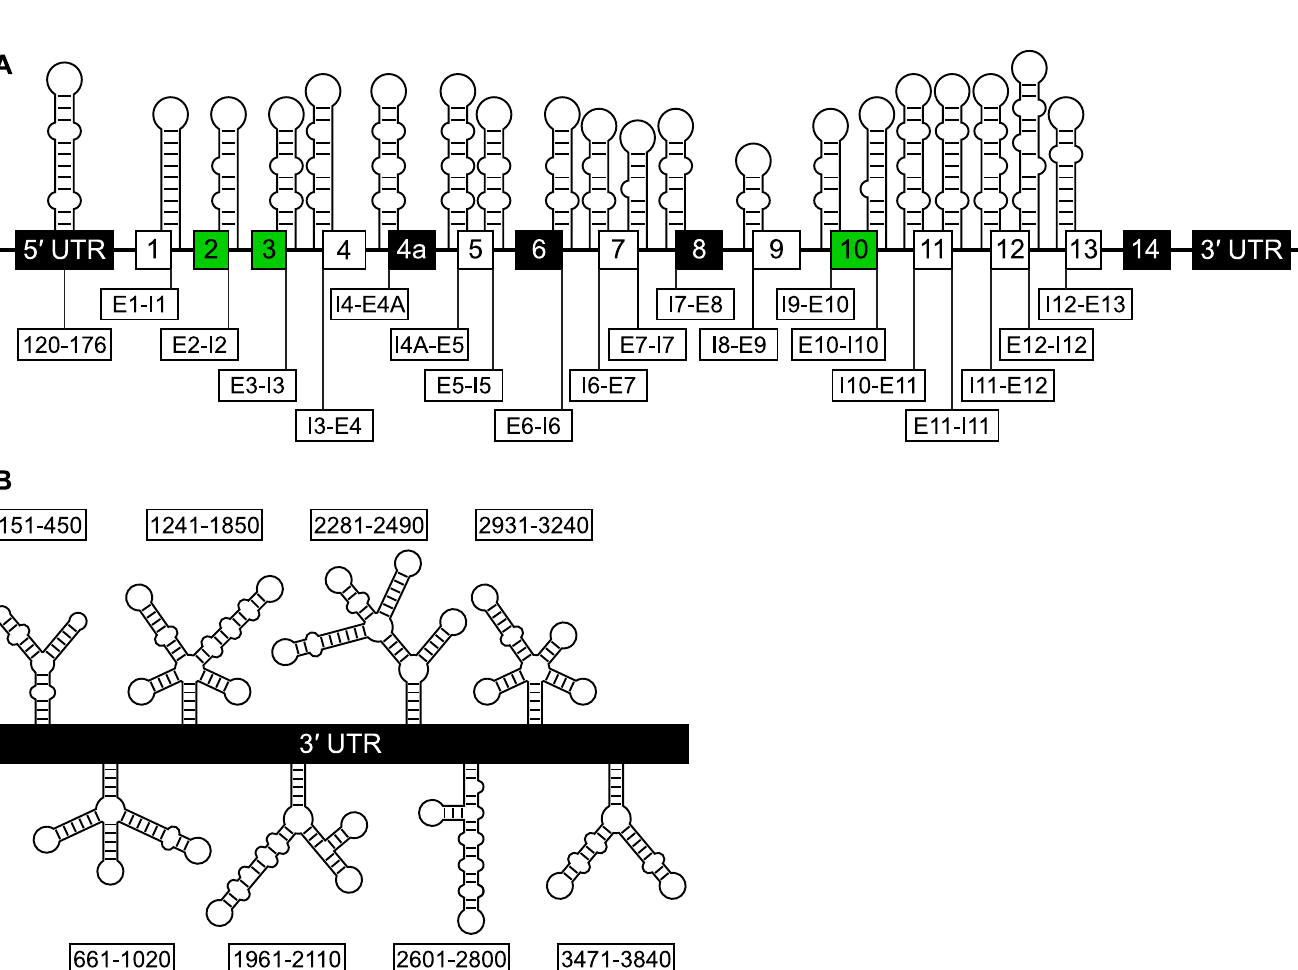
Fig 2. Overview of structured regions in the tau pre-mRNA. (a) Conserved structures in the 5 0 UTR and exon-intron junctions. White boxes indicate constitutive exons. Black boxes indicate exons that are excluded in the human brain. Green boxes indicate exons that are alternatively spliced. (b) Conserved structures identified in the 3 0